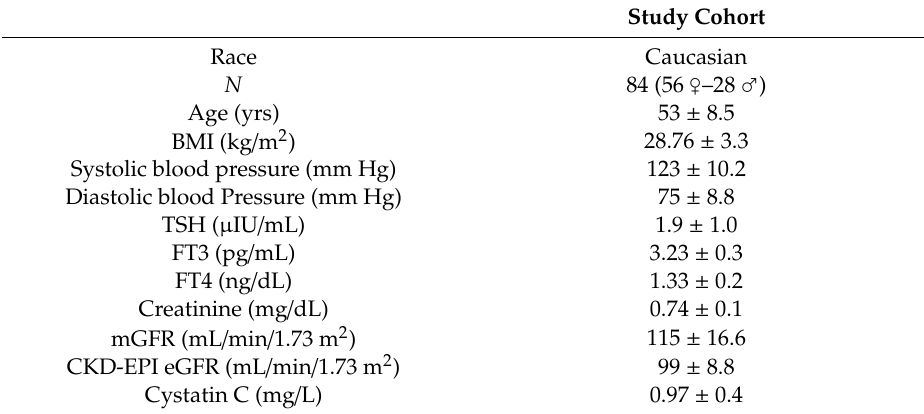
Table 1. General characteristics and laboratory parameters of the study